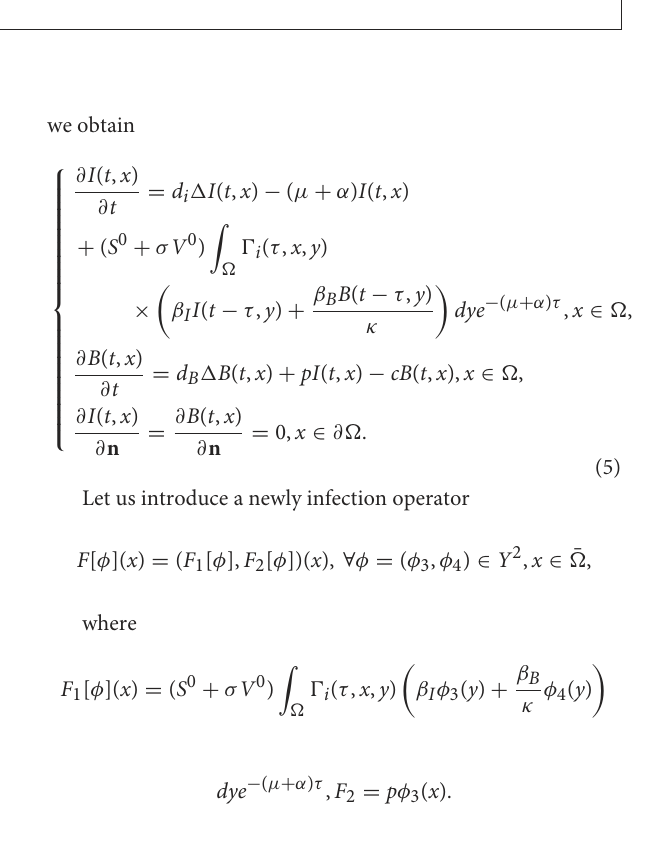
FIGURE1 Flowchart of model (Equation 1). The blue box denotes the susceptible cattle, the green box represents the vaccinated cattle, the purple box stands for the density of FMDV in the contaminated environment, and the combined box denotes the infected cattle including the exposed cattle and the symptomatic